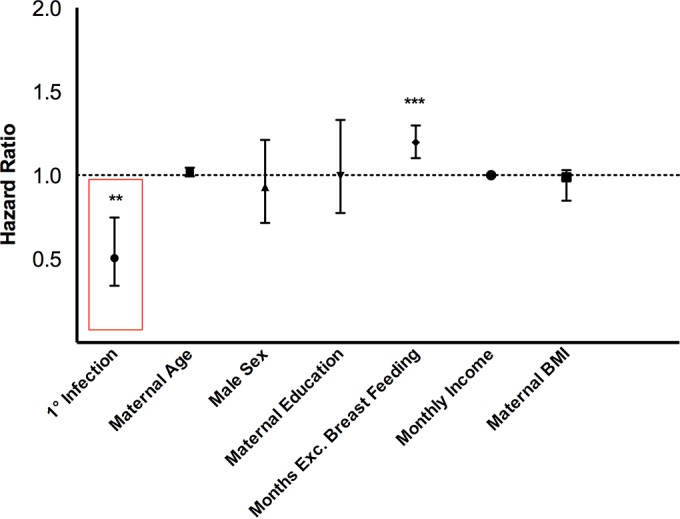
Primary rotavirus infection decreases the risk of subsequent rotavirus infection. We used a Cox regression to estimate the independent time-dependent impact of a primary symptomatic rotavirus infection on the risk of secondary symptomatic infection among infants in our cohort in the first 3 years of life. Maternal age at birth, male sex, maternal education, cumulative months of exclusive (Exc.) breastfeeding, monthly income, and maternal BMI at birth were included in the model as time-independent covariates. Hazard ratio estimates are plotted with 95% confidence intervals for each variable included in the survival model. * indicates the level of significance, with ** indicating a P value of <0.001 and ** a P value of <0.0001.